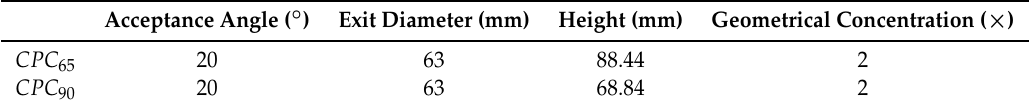
Table 1. Dimensions used of CPC 90 and CPC 65 .